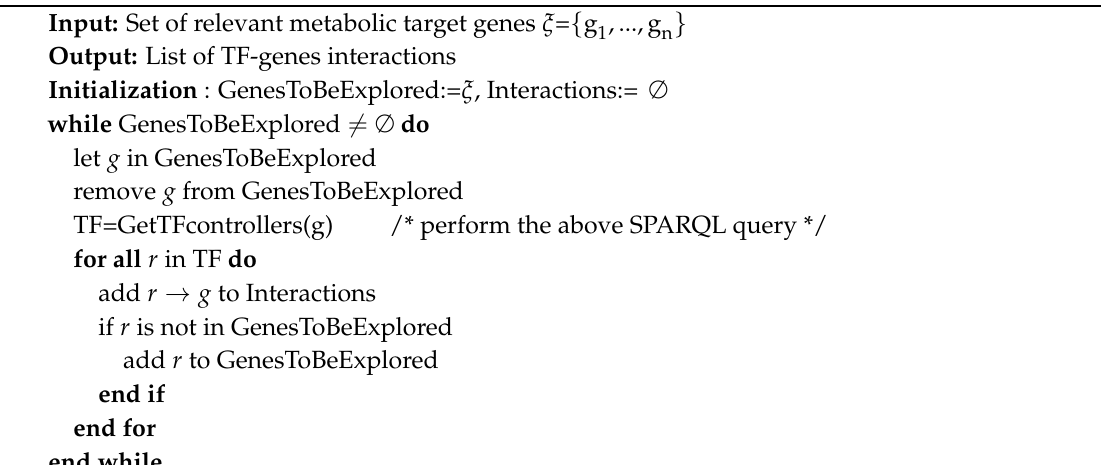
Algorithm 2: Reconstruction of regulatory network using Pathway Commons SPARQL